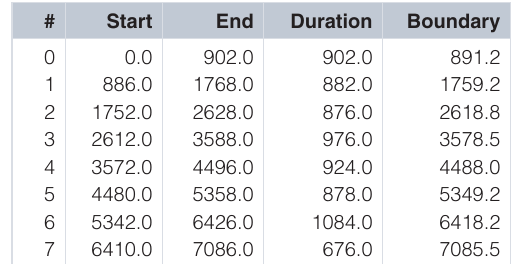
Table 4. Position of the fMRI stimulus segments with respect to the movie annotation time. The last column lists the position of the scene boundary used as a reference for the segment transition. All times are in seconds and refer to the full (unsegmented) stimulus, which is a shorted version of the original movie 1